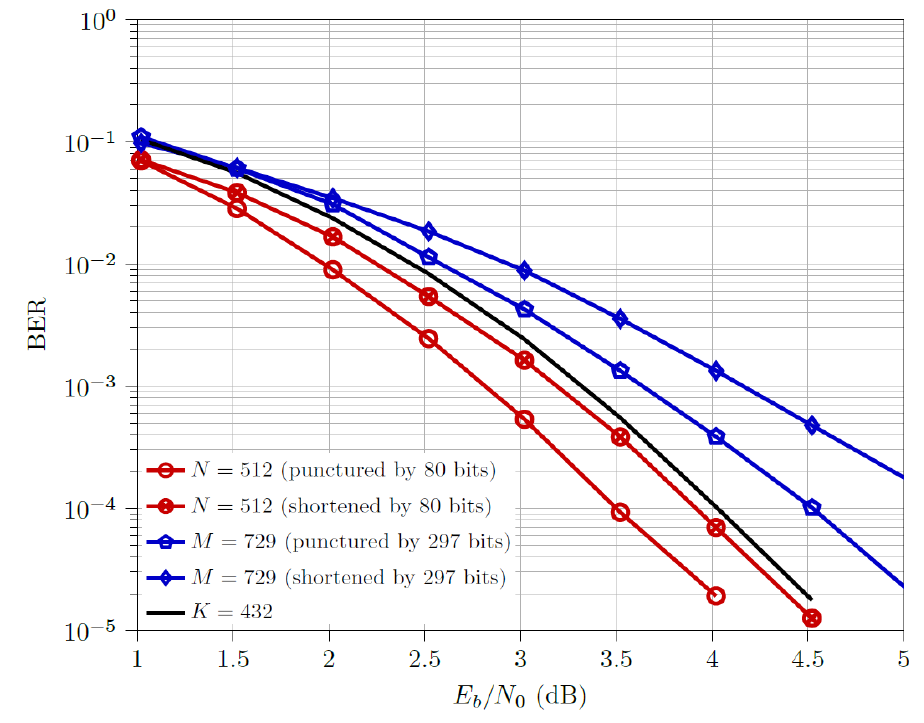
Figure 6. BER performance of Scenario 2 for R d = 1/4.